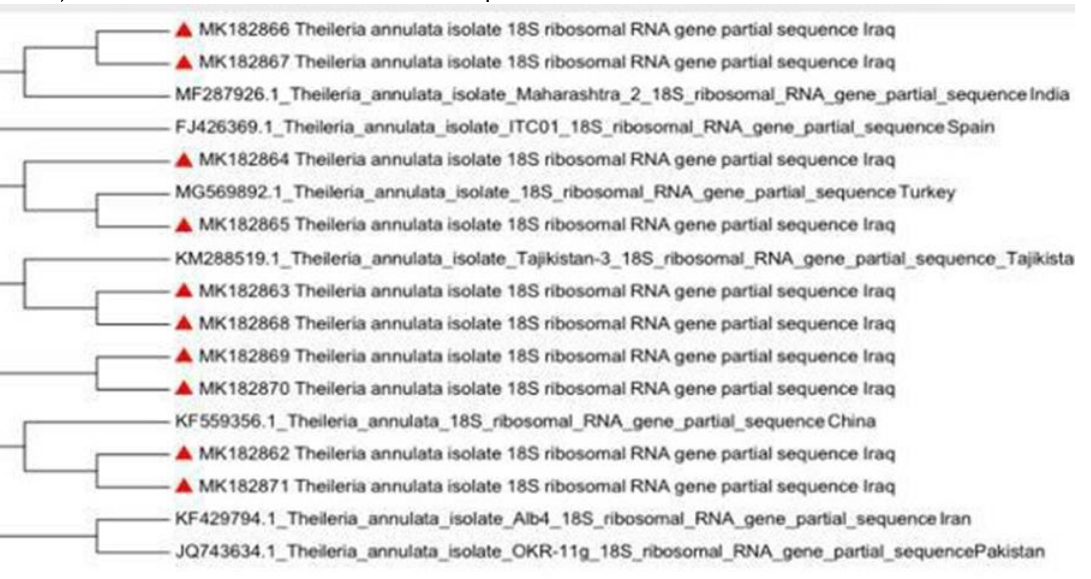
Figure, 5: Analysis of phylogenetic tree based on the partial sequence small subunit of 18s rRNA of Theileria spp. , local and global sequence using neighbor joining bootstrab 1000 radiation tree figure evolutionary